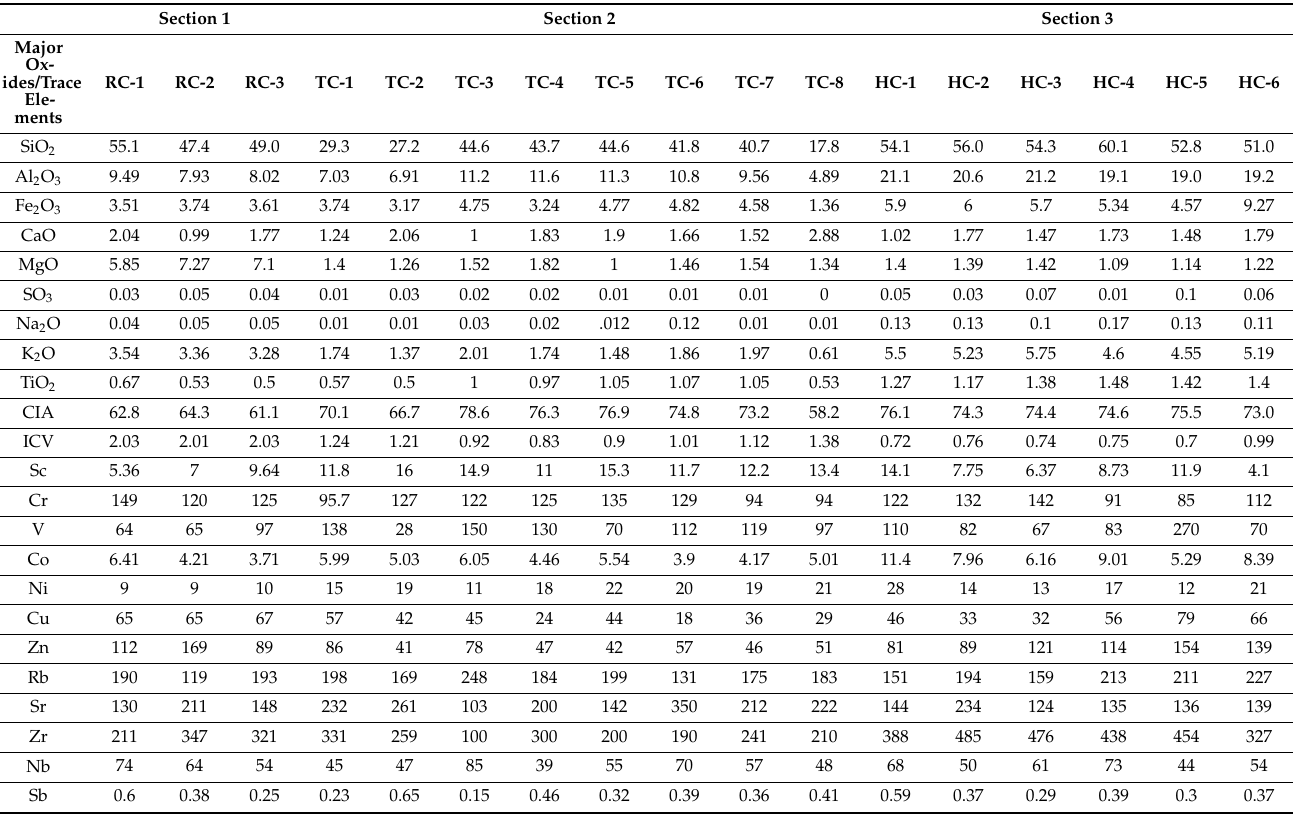
Table 1. Major and trace element data for whole-rock samples of the Chichali Formation. The concentration of major components is expressed as wt%, while trace element concentration is in ppm. CIA is an abbreviation for Chemical Index of Alteration, while ICV is an abbreviation for Index of Compositional